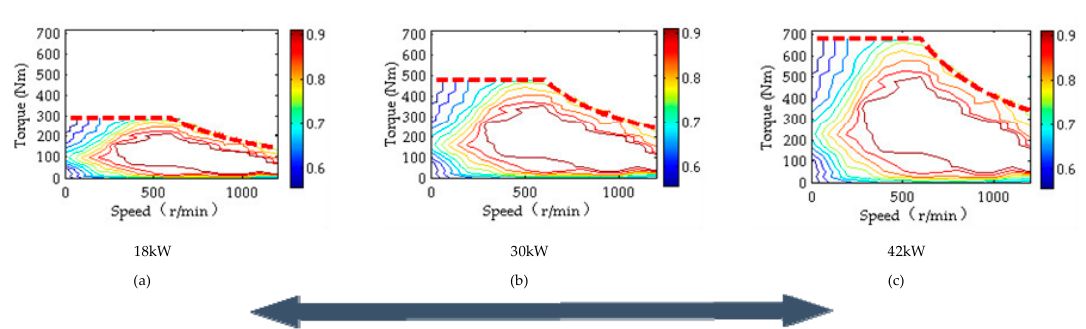
Figure 2. The efficiency maps of the ( b ) baseline and ( a , c ) two scaled motors.